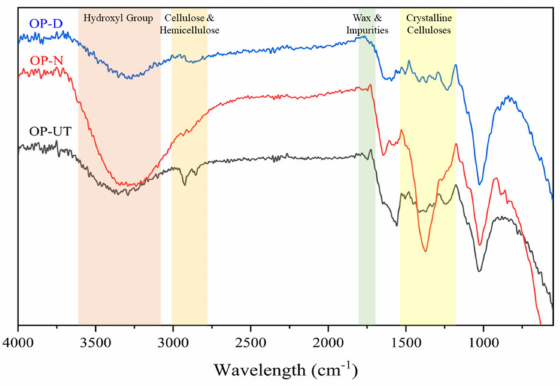
Figure 2. FTIR spectra of the raw filler (OP-UT) and treated filler (OP-N and